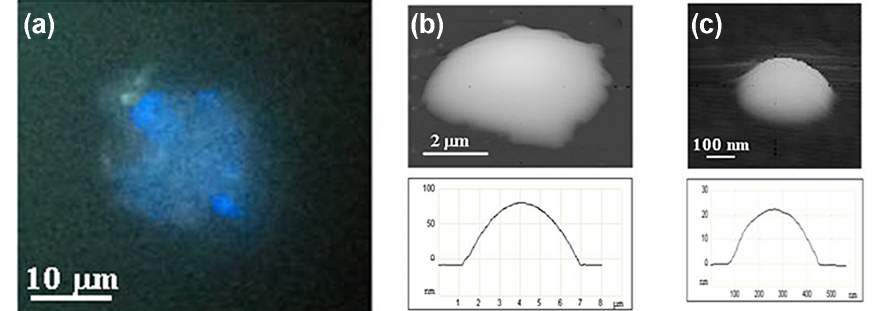
Figure 9. (a) Dispersed fuel oil droplets observed under an optical microscope with DAPI staining; (b) three-dimensional views of typical nanometre-sized fuel oil droplets in the natural seawater sample taken at the Rt Murva depth of 0m; (c) depth of 5m visualized by AFM with the corresponding vertical profiles. Vertical profile enables to calculate oil droplet diameter in seawater (adopted from Ivoševi´c DeNardis et al.,